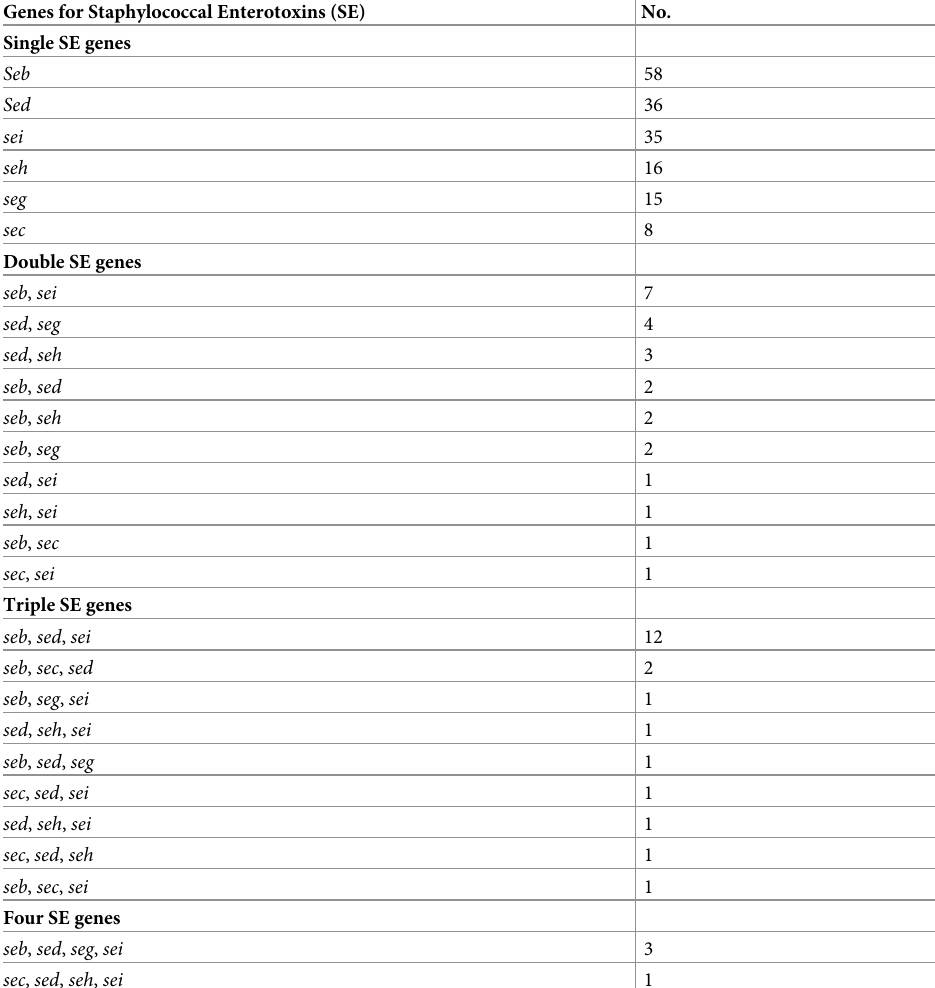
seb , sei and seb , sed , sei detected in 7 and 12 isolates respectively. Four isolates were positive for four SE genes (Table 5). Correlation between CRP, antibiotic resistance and virulence factors There was no association between CRP values and gender, antibiotic resistance, biofilm forma- tion, ACME or toxin production. Similarly, no association between biofilm formation and the presence of central or peripheral lines was found. However, biofilm formation was signifi- cantly associated with antibiotic resistance in S . epidermidis isolates. Biofilm- producing S . epi- dermidis isolates (N = 52; 98.1%) positive for mecA gene were more than biofilm-negative isolates (N = 17; 73.9%). In contrast, arc (gene for ACME) was significantly (P = 0.004) more